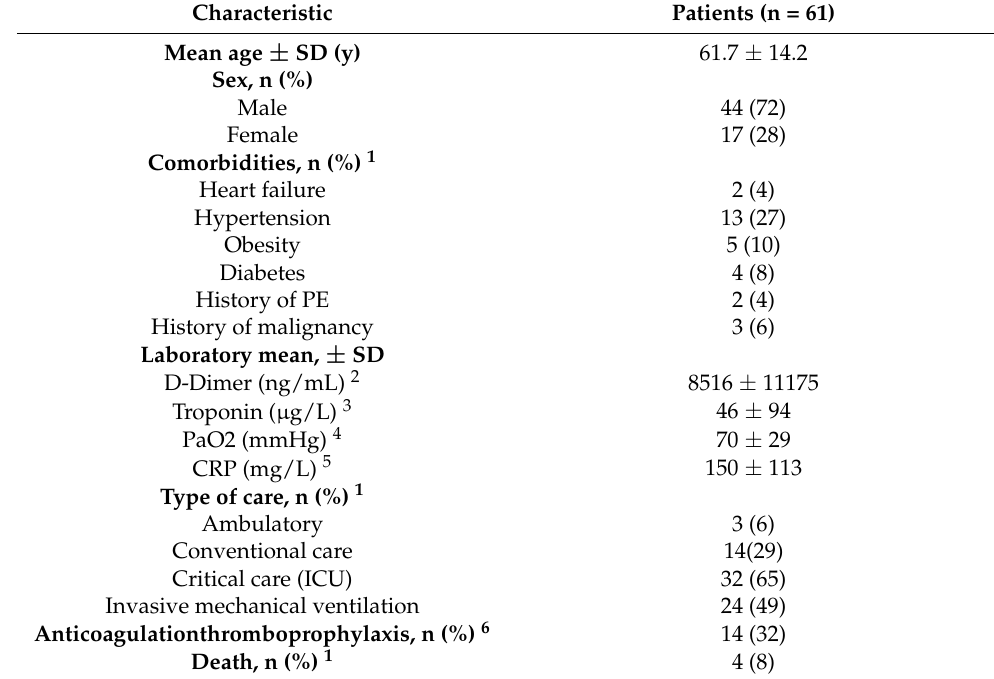
Table 1. Patient